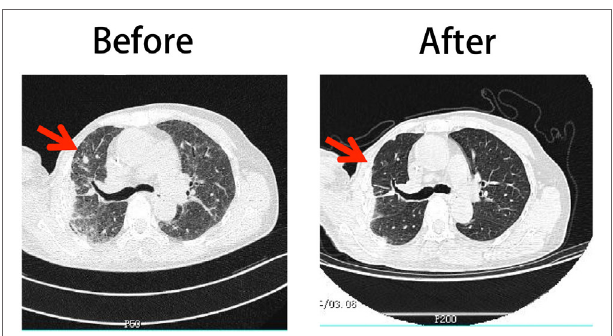
FigUre 6 | Comparison of the patient’s CT scan images before and after Herceptin-treated natural killer (NK) cell therapy. The left column shows the image obtained before treatment and the right column shows the image obtained after four cycles of NK cell therapy.